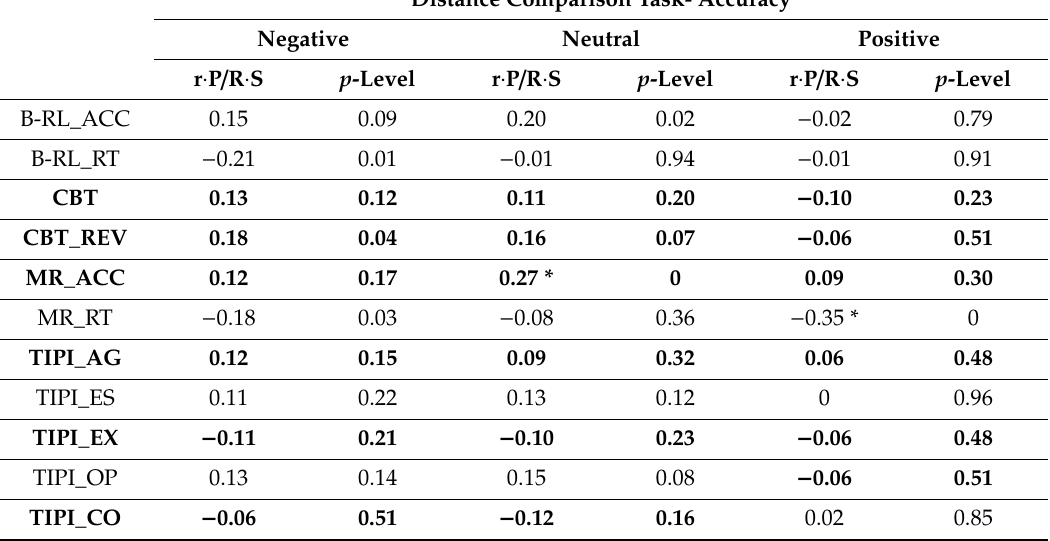
Table 3. The table shows the correlation indexes (and the corresponding p -levels) between cognitive tasks, personality traits, and accuracy at the distance comparison task. Pearson correlations (r · P) are reported in bold. The Spearman correlations (R · S) are not in bold. The asterisk (*) indicates the correlations that survived to the correction for multiple